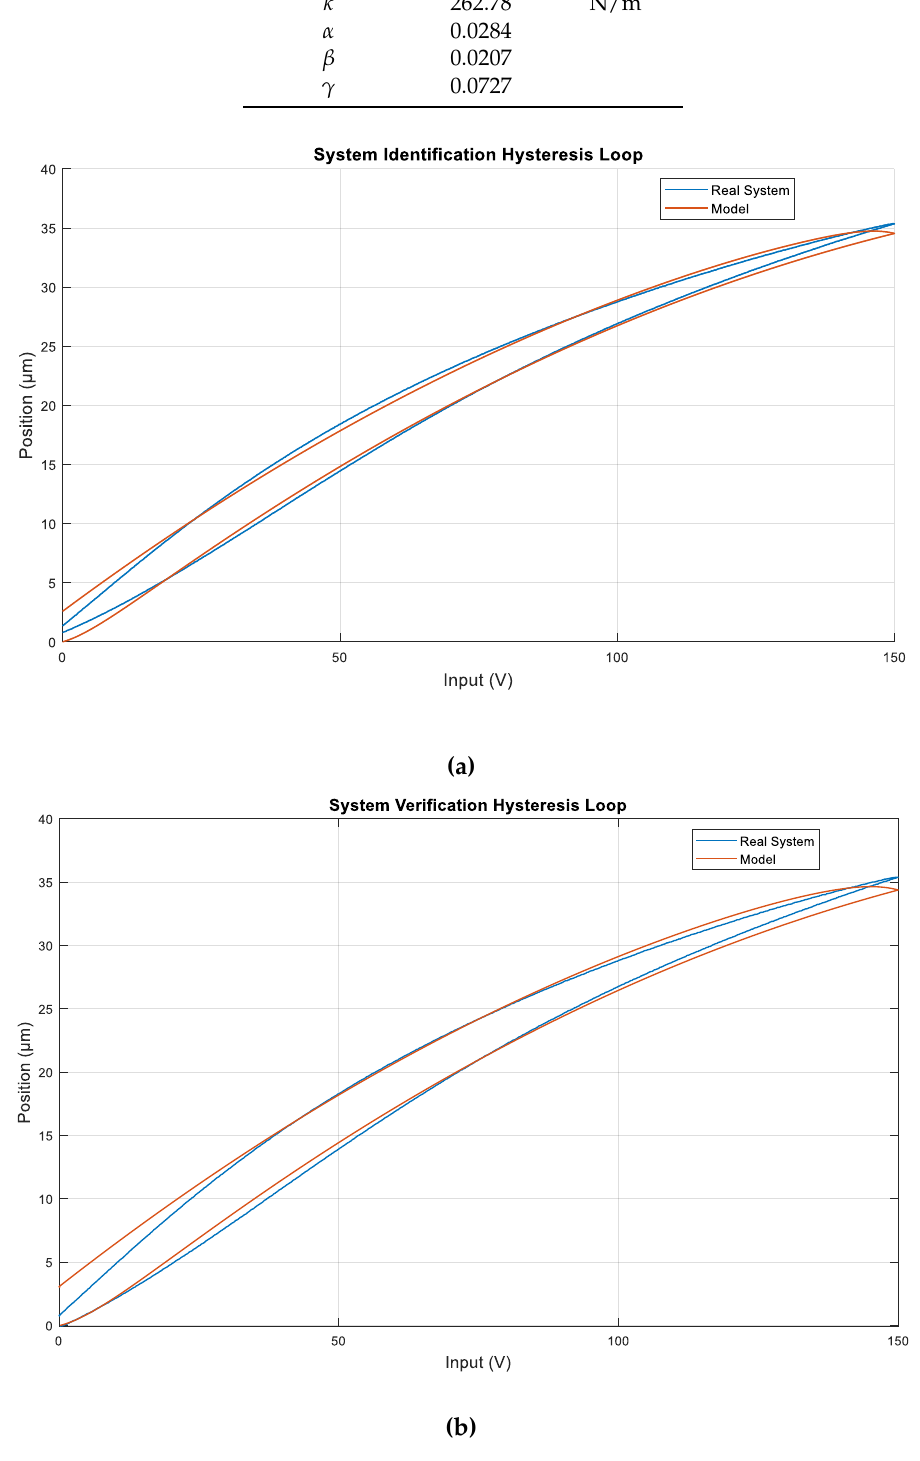
Figure 3. Modelled hysteresis loop: ( a ) System Identification, and ( b ) System Verification.